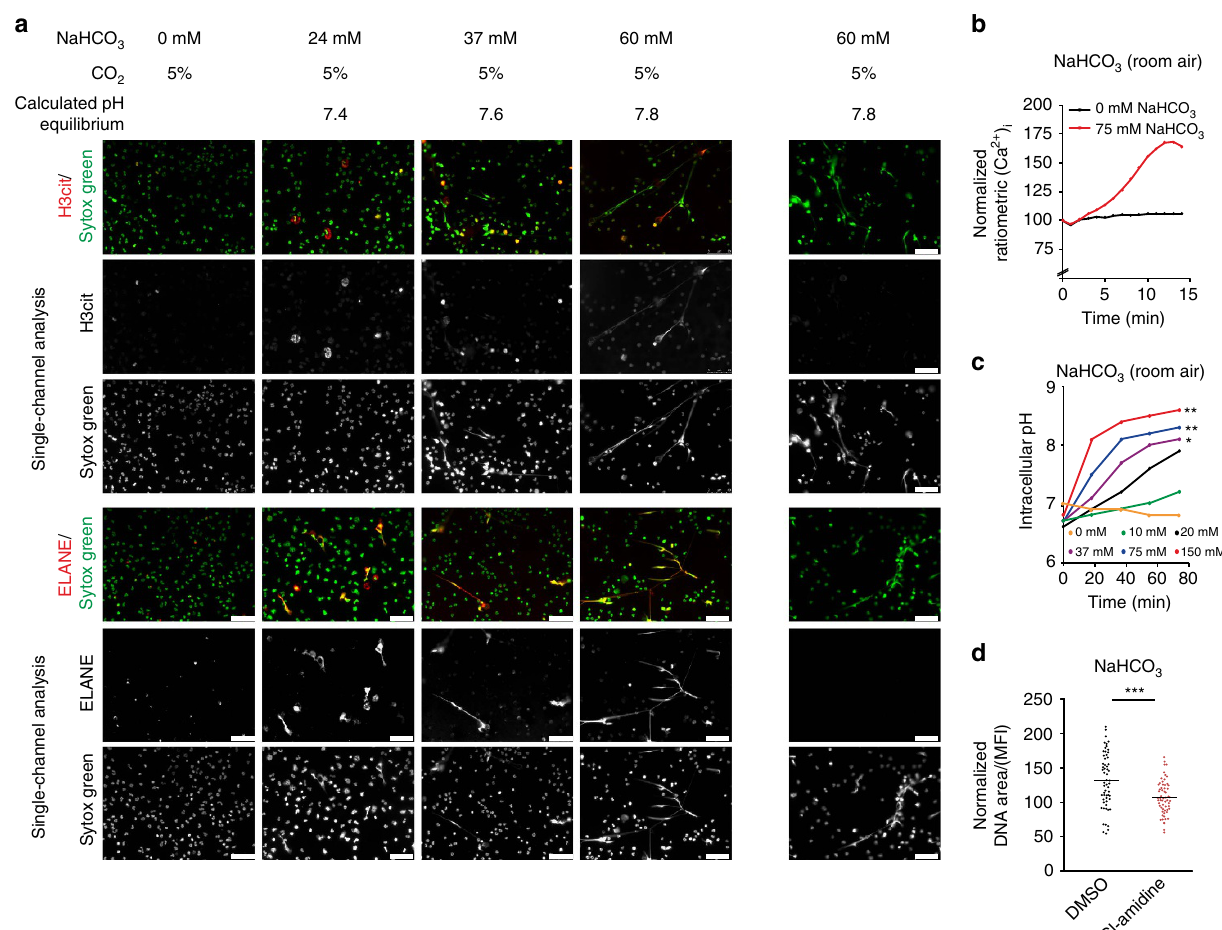
Figure 4 | NaHCO 3 -induced cellular changes support PADI4 activity. ( a ) Freshly isolated human neutrophils from the peripheral blood of healthy donors were cultured on glass coverslips for 120min at 37 (cid:2) C/5% CO 2 and subjected to isotonic HBSS media containing different concentrations of HCO 3 (cid:2) . The calculated pH equilibrium of the bicarbonate–CO 2 buffer system of these media at 37 (cid:2) C/5% CO 2 is specified. Immunocytochemistry of H3cit (top) and neutrophil elastase (bottom), and the respective DNA SYTOX counterstain in both overlay as well as single-channel analyses are provided. Please note the absence of H3cit þ ELANE þ extracellular chromatin in the absence of NaHCO 3 . The presence of NaHCO 3 in the media leads to marked increases in H3cit þ ELANE þ extracellular chromatin reminiscent of NETs (representative pictures of one of three independent experiments are shown). ( b ) Ratiometric determination of the cytosolic Ca 2 þ concentration revealed the elevation of [Ca 2 þ ] I induced by 75mM NaHCO 3 ( n ¼ 4 independent experiments). ( c ) The intracellular pH of human neutrophils was measured by flow cytometry employing SNARF as pH-sensitive dye under ambient pCO 2 . Note the time- and bicarbonate-concentration-dependent increase of the cytoplasmic pH ( n ¼ 3 independent experiments, mean þ s.e.m.). ( d ) Chromatin externalization by 50mM bicarbonate was induced in human granulocytes from healthy donors in the presence or absence of the PADI inhibitor Cl-amidine (1mM) and images of propidium iodide fluorescence as in Supplementary Fig. 8H were morphometrically analysed. The nuclear decondensation is